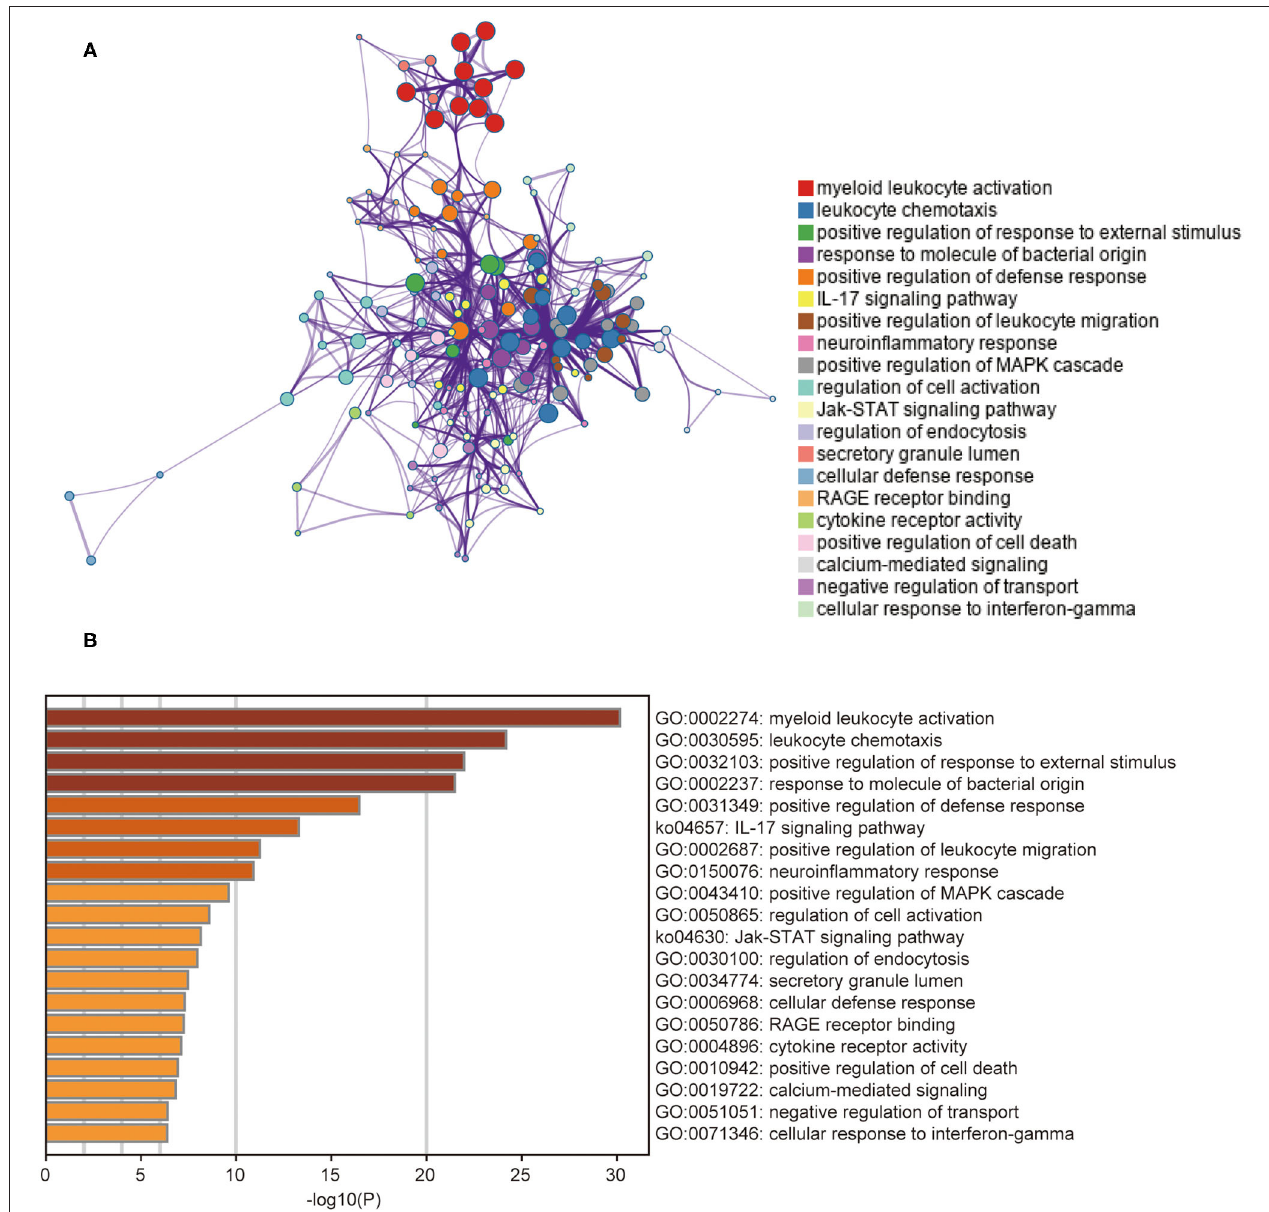
FIGURE 3 | The results of gene functional enrichment analysis. (A) The network of the top 20 clusters of enriched terms. Cluster identity is represented by color, the similarity score is represented by the thickness of the edge, and terms with a similarity score > 0.3 are linked by an edge. (B) Heat map of the top 20 clusters. Cluster identity is represented by color; the smaller the P -value the deeper the